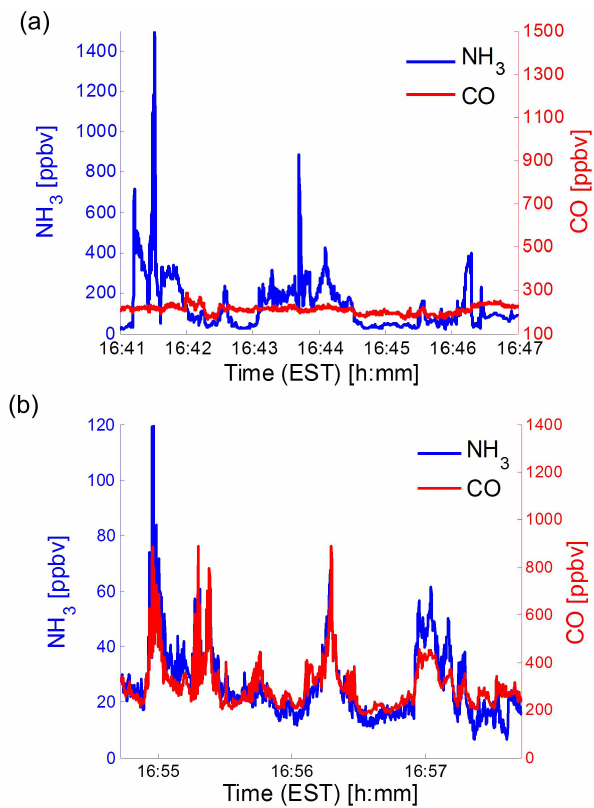
Fig. 11. (a) Time series of NH 3 measurements at an animal farm in central New Jersey; (b) on-road measurements in the Princeton, New Jersey area, with transient spikes correlated with CO emissions from